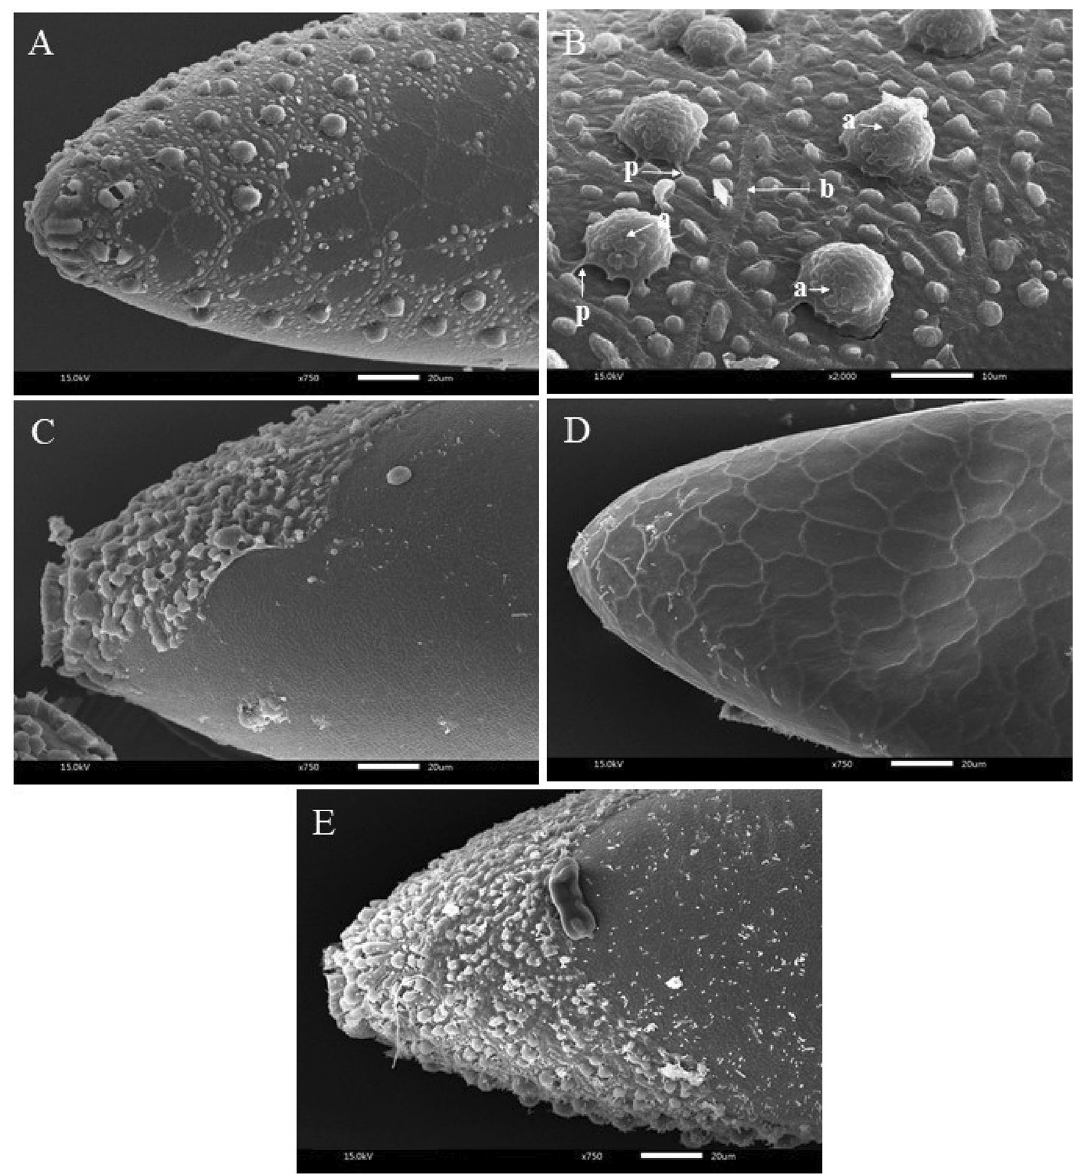
Figure 2. Scanning electron micrographs of Aedes albopictus eggs: ( A , B ) non-treated egg, intact exochorionic cuticle with cell borders (b), papillae (p), and aeropyles (a), morphological damage to exochorionic cuticle after treated with d-limonene ( C ), geranial ( D ), and trans -cinnamaldehyde ( E thickness of 5% phenyl-methylpolysiloxane coating), an electron ionization system with 70 eV electron energy (30–500 m z −1 ), and an Agilent 6890-N gas chromatograph (USA) made up the GC–MS system. The column temperature was programmed to increase gradually from room temperature to 50 °C and stay there for 2 min. The column temperature was then increased to 200 °C and maintained there for 3 min at a rate of 10 °C min −1 . In the final stage, the column temperature was raised to 260 °C at a rate of 15 °C min −1 and held there for 20 min. The injector and detector temperature were held at 270 °C. The total running time was 40 min. A mass spectra search program with Wiley 7 N library was used for identifying all components of EOs. The mass spectra of peaks were compared with those stored in Adams 53 and NIST 17 54 libraries. Temperature-programmed reten- tion indices (RI) were determined using n -alkanes (C 7 –C 30 ). The experiment was performed in three replicates. Source and purity of reagents. Cinnamaldehyde (98% pure), a major constituent of C . verum EO, d-limonene (96% pure), a major constituent of C . aurantium EO, and geranial (96% pure), a major constituent of C . citratus EO together with standard n -alkanes (C 7 –C 30 ) were supplied by Sigma-Aldrich company (USA). Temephos (1 ppm), the positive control, was obtained from Thailand’s Government Pharmaceutical Organiza- tion (GPO) (Pathum Thani, Thailand). Ethyl alcohol (95% v/v ) was supplied by Thailand’s Liquor Distillery Organization (Chachoengsao, Thailand). All chemicals used in this study were reagent-grade.